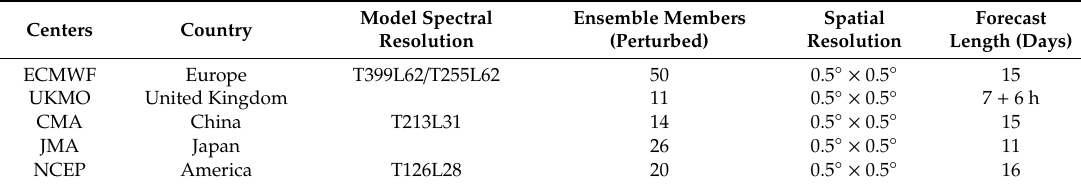
Table 1. Ensemble prediction systems of different centers.